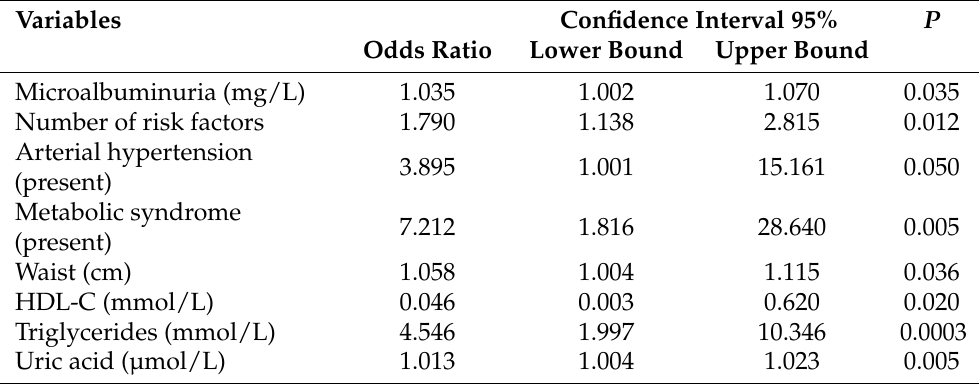
Table 5. Variables with a statistically significant effect on the presence of carotid plaque (N = 9) in univariate logistic regression analysis. Gender is not a significant predictor.